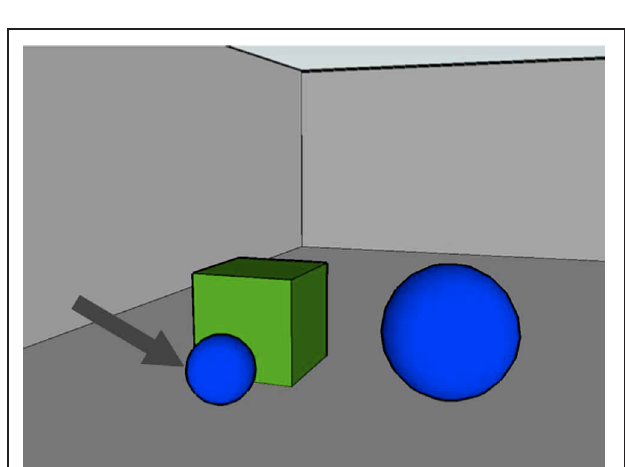
FIGURE 2 | Visually simple stimuli from a complex linguistic task (“Describe the object the arrow is pointing to”; Viethen and Dale,